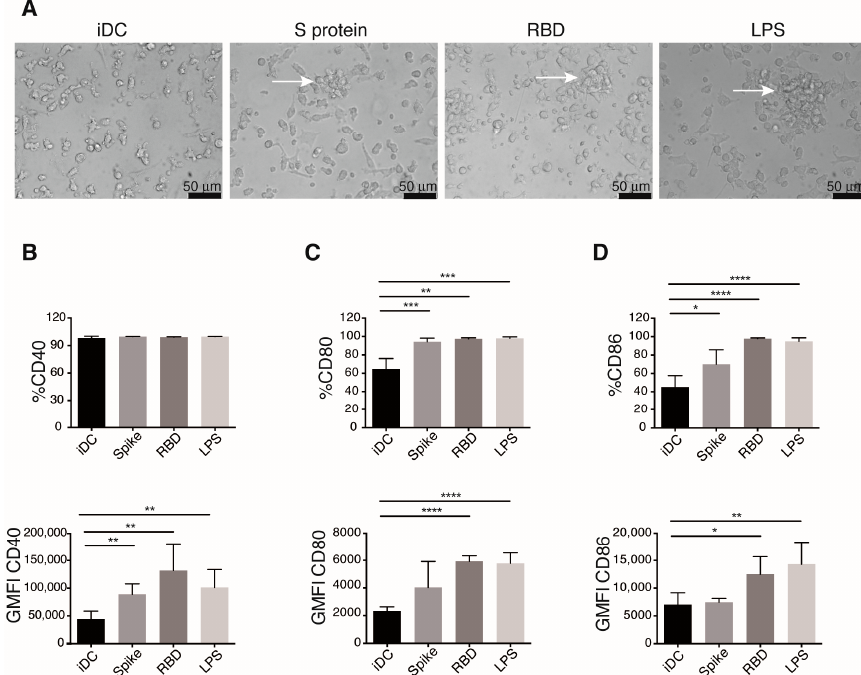
Figure 2. Spike protein and the RBD of SARS-CoV-2 promote iDCs activation. Twenty-four hours after the addition of indicated stimulus DCs, populations were observed by microscope, stained, and analyzed by flow cytometry for the expression of the co-stimulatory molecules. ( A ) Activation in stimulated DCs marked by cells clusters formation (arrows) were documented by bright field microscope photography. Representative images of at least five experiments are shown. Expression of co-stimulatory molecules CD40 ( B ), CD80 ( C ), and CD86 ( D ), was determined. Percentage of positivity (upper) and GMFI (lower) are shown. Mean ± SEM. Values of the untreated iDC condition were compared to those of the different treatments using t test. n = 6 donors for iDC, Spike, and LPS conditions; n = 5 donors for RBD. Only significant differences are indicated. * p < 0.05, ** p < 0.02, *** p < 0.01, **** p <